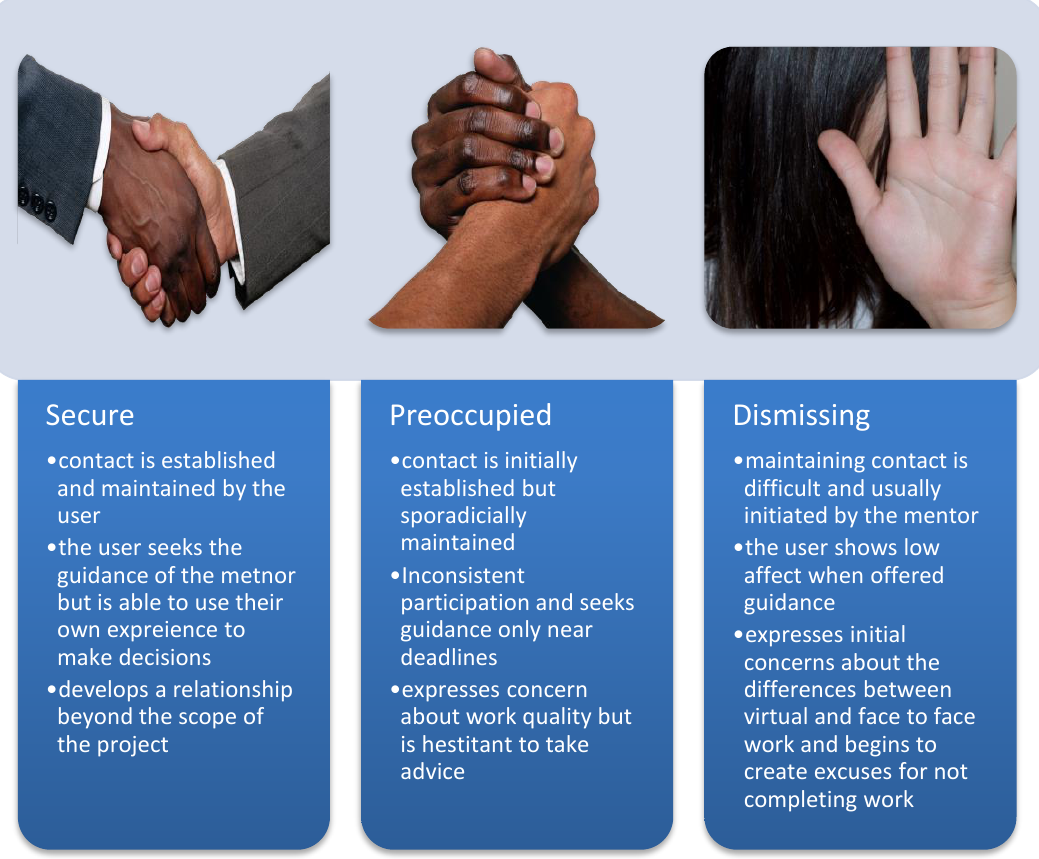
Figure 2. Understanding Virtual Attachment